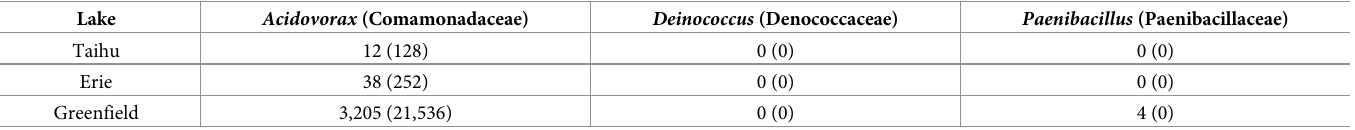
Table 4. Metatranscriptome and metagenome reads recruited to the glcD gene of Acidovorax JMULE5, Deinococcus JMULE3, and Paenibacillus JMULE4. Libraries from Lake Erie metatranscriptomes (Steffen et al., 2017; Stough et al., 2019), Taihu metatranscriptomes (Stough et al., 2019), and Greenfield metagenomes were recruited to each glcD